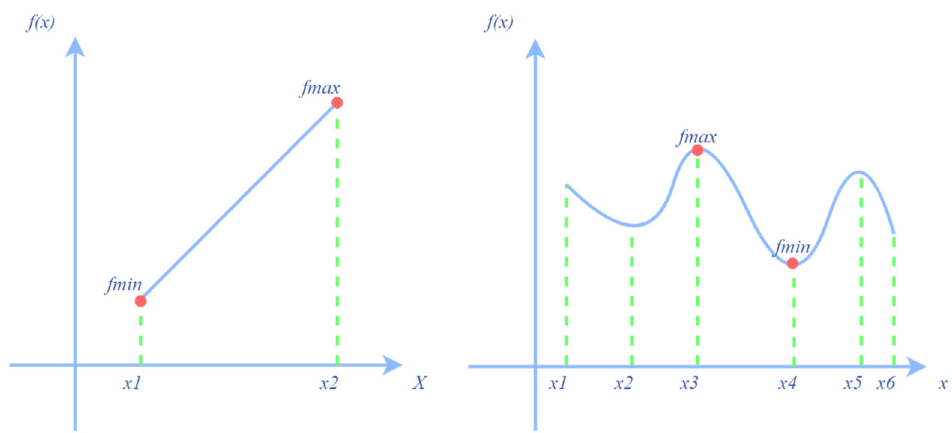
Figure 5. Linear and nonlinear function graphs.